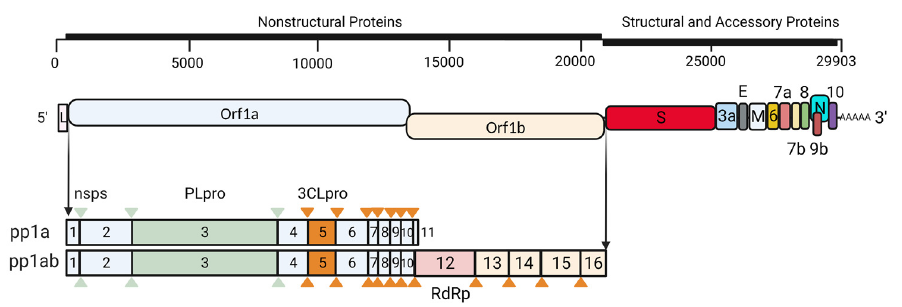
Figure 1. Schematic presentation of SARS-CoV-2 genome and encoded proteins. SARS-CoV-2 en-codes 29 proteins including 4 structural proteins, 16 non-structural proteins (nsps), and 9 accessory proteins. Polyprotein pp1a and pp1ab are cleaved by PLpro or 3CLpro as indicated by triangles with different colors to generate 16 nsps.